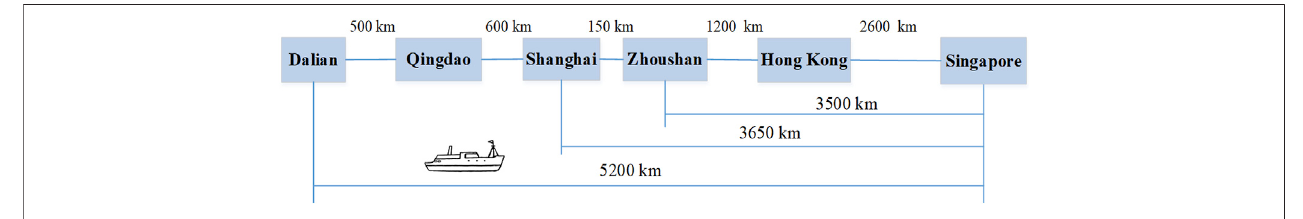
FIGURE 5 | Navigation routes with intermediate ports and distances.